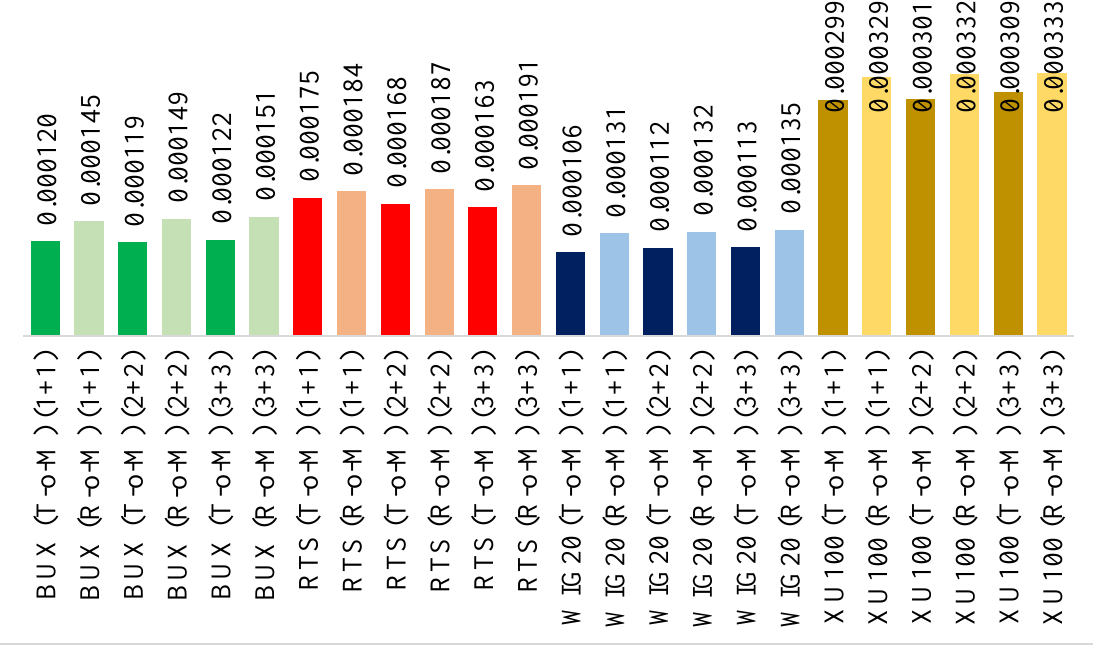
Table 6. Results of the statistical significance tests—Daily volatilities (alternative 2).